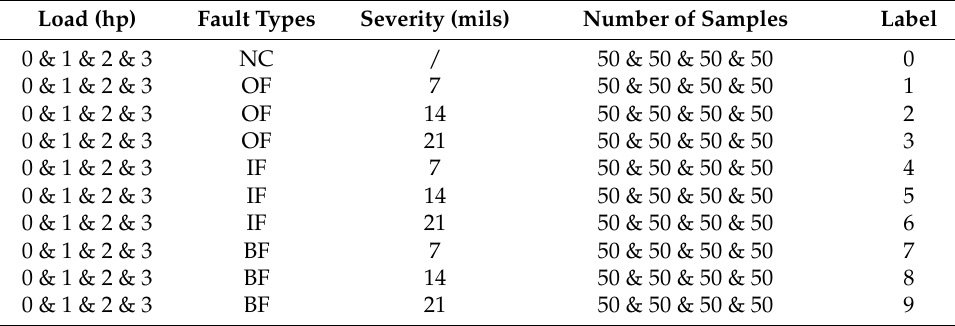
Table 7. Description of the CWRU bearing